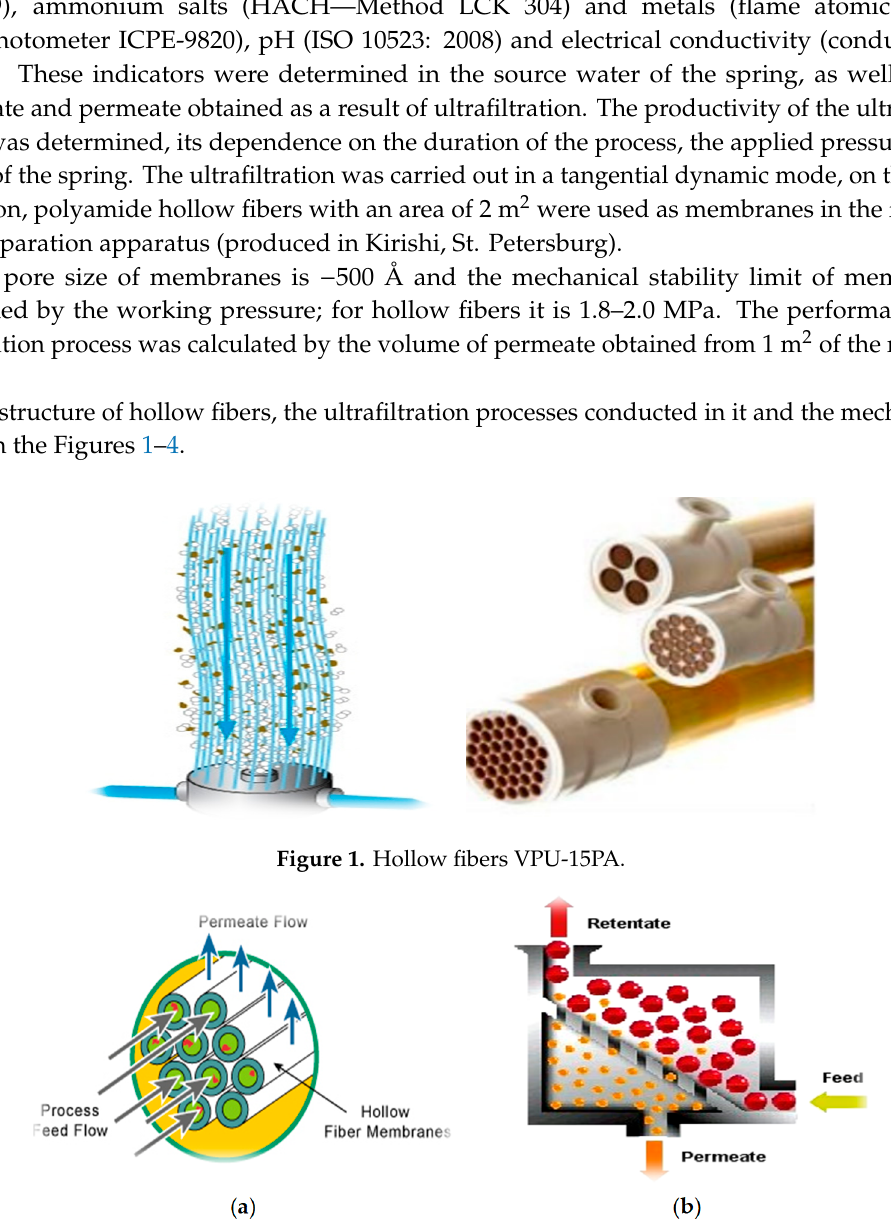
Figure 2. The mechanism of the ultrafiltration: ( a ) Hollow fibers ultrafiltration mechanism, ( b ) Fractional separation during ultrafiltration.